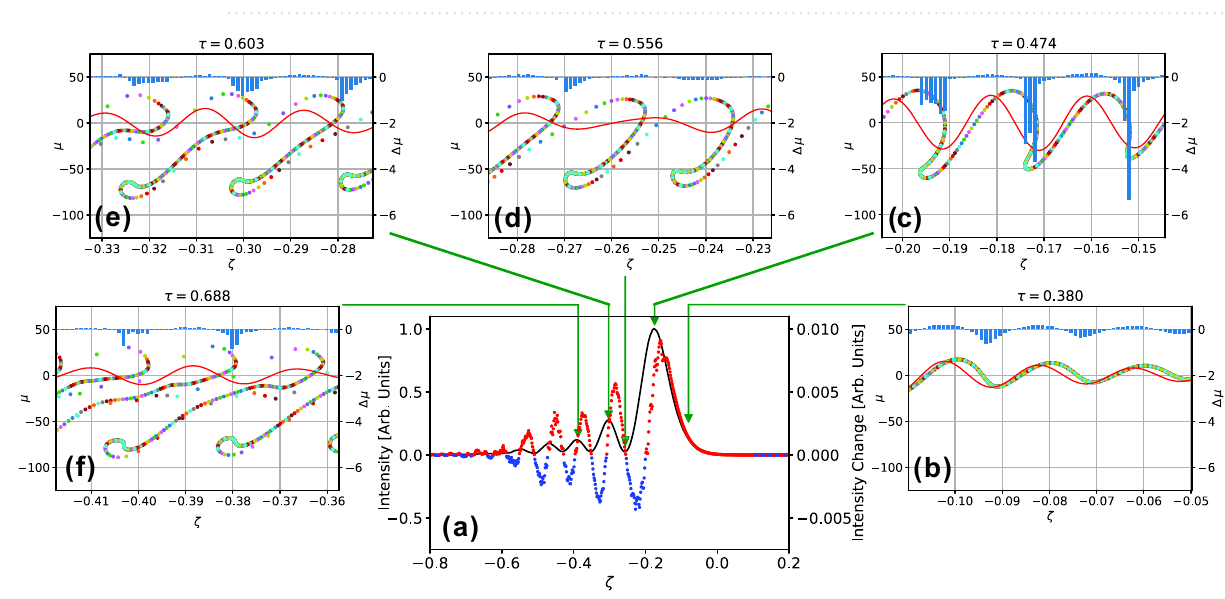
Figure 4. ( a ) Simulated FEL pulse at the end of the macropulse for the photocathode mode and local intensity changes in a single round trip, including the cavity loss of 3%, with red dots for amplification and blue dots for reduction. ( b )–( f ) snapshots representing the macroparticle distribution at different positions in the undulator for a specific bunch slice. The red lines in the snapshots indicate the electric field of the FEL pulse, and the blue bars are local changes in the macroparticle energy. The longitudinal variable, ζ = ( z − ct )/ L s , is defined in a coordinate system moving at the vacuum speed of light c and normalized by the slippage distance L s